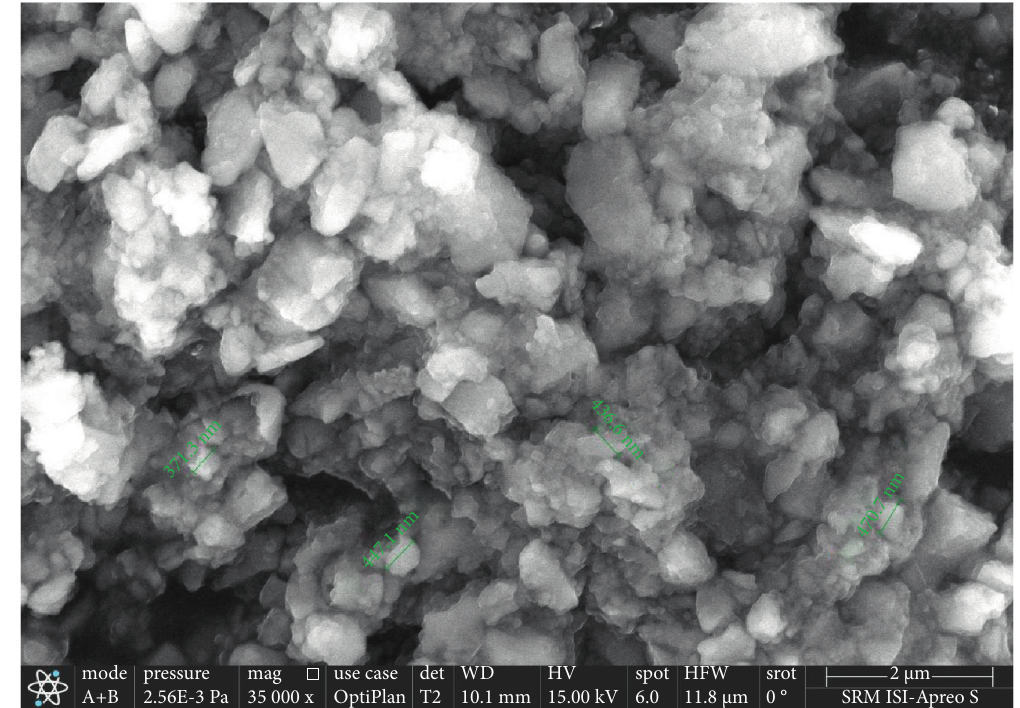
Figure 2: SEM image of control 3M Filtek Z250 composite.